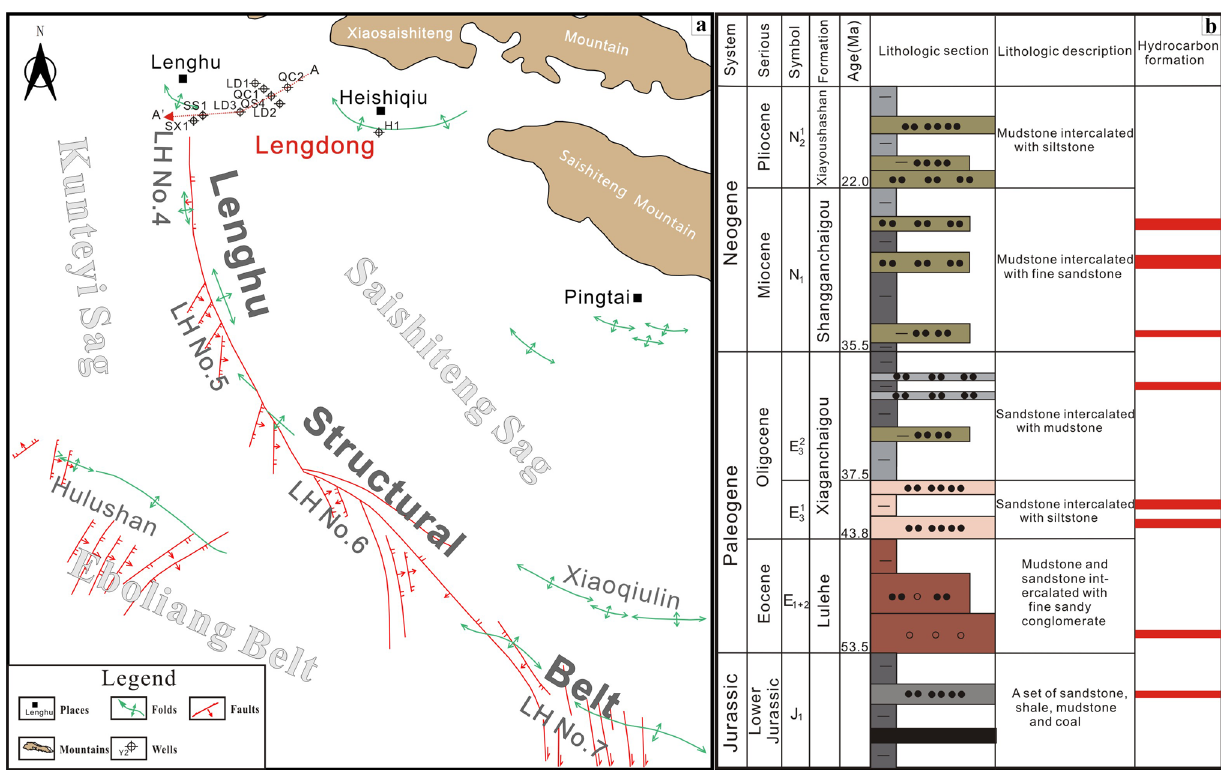
Fig. 2 a Structural location of Lenghu area and location of Lengdong in Lenghu area. b Stratigraphic divisions, lithology and hydrocarbon for- mations in Lengdong area. (modified from Ref. Tian et al. 2018; Zhao et al.